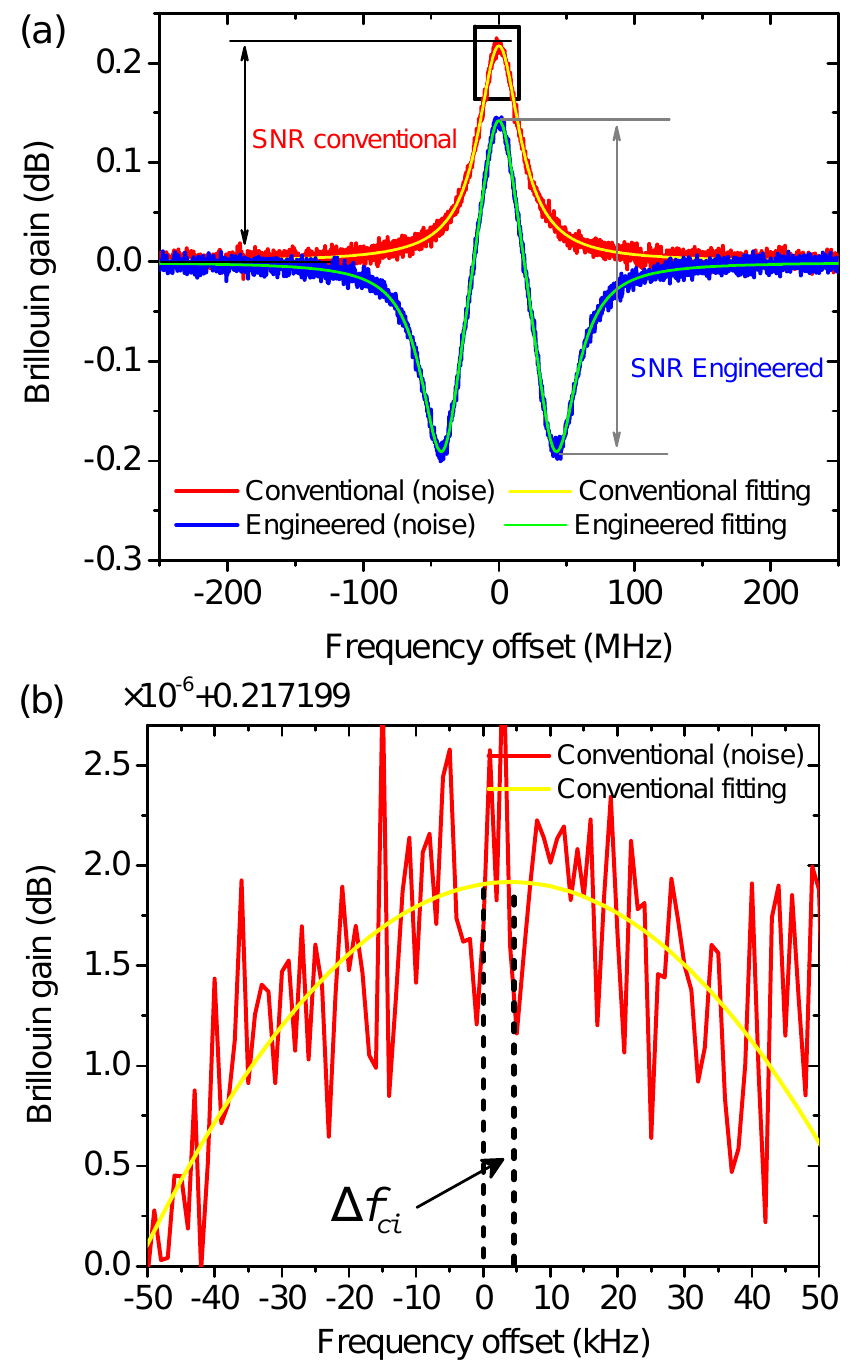
Figure 2. ( a ) Typical conventional (red) and engineered (blue) simulated BGS ( d = 1) with the same noise level and their corresponding fitting curves. The conventional BGS is excited by a 100 ns pump pulse with a spectrum FWHM of 54 MHz; ( b ) the magnified peak area of the conventional BGS (rectangular area in ( a )), highlighting the BFS estimation error ∆ f ci due to the noise in the i th